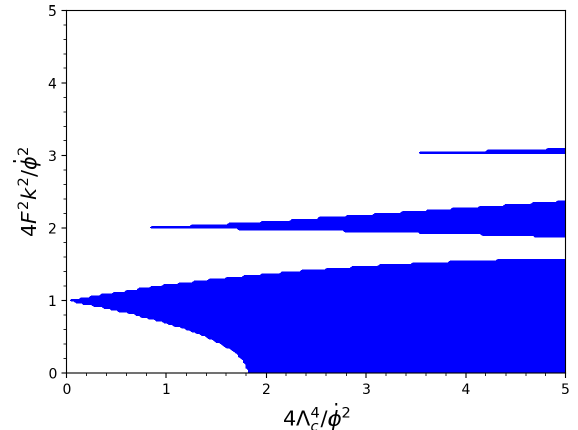
Figure 3 . The plot shows the instability regions of eq. (3.31) where ˙ φ = 10 8 GeV , F = 10 9 GeV , F 0 = 10 11 GeV , Λ c = Λ 0 = 10 3 GeV and α = 10 − 4 and ν = 10 − 2 . Inside the blue area, the solution grows c exponentially such that the axion fragmentation provides additional source of friction for relaxion stopping